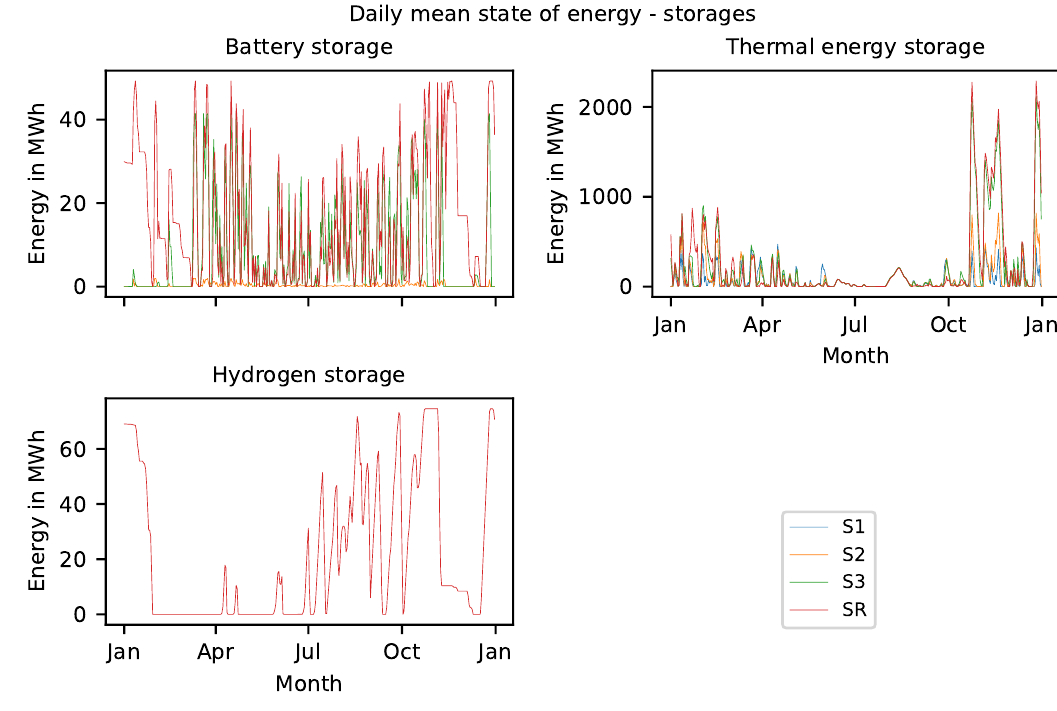
Figure 9. Daily mean states of energy. (Source: own representation).